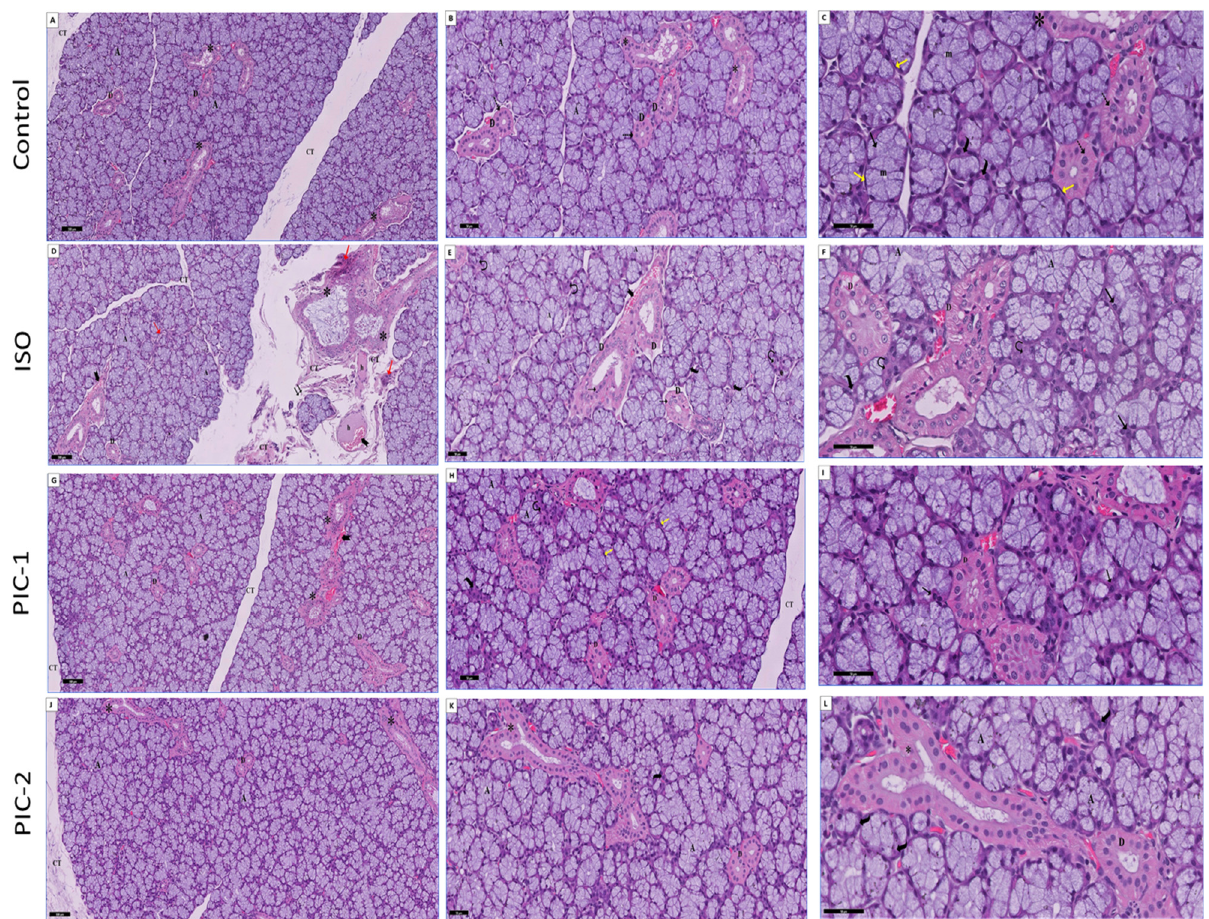
Figure 3. A section in the sublingual gland stained with HE from the control group ( A – C ) showing sublingual gland mucous acini and ducts appear with a fine network of interlobular connective tissue (CT). Each mucous acinus (A) consisted of large pyramidal mucous cells with abundant pale blue vacuolated cytoplasm. Acinar mucous cells contain flattened basal nuclei and pale eosinophilic cytoplasm ( ↑ ). A serous demilune is seen at the left of the acinus with rounded nuclei, and basal dark linear stain (wavy arrow). The striated duct is lined by columnar cells having eosinophilic cytoplasm and prominent cytoplasmic striations (dot arrow). The excretory ducts (*) have tall columnar epithelium with more apically located nuclei. Myoepithelial cells (yellow arrow) show a narrow cytoplasm and a very flattened nucleus, may be found wrapping ducts and some acini. (HE; A × 100, B × 200, C × 400). ISO group ( D – F ) showing markedly hypertrophic packed secretory mucous acini (A) with some areas with shrunken (curved arrow) loss of the acini ( ↑↑ ). A serous demilune is seen with vacuole-like structures (wavy arrow). Striated duct (D) appears disorderly arranged epithelium lining with loss of basal striation and marked vacuolation (dot arrow). Execratory ducts (*) appear with loss of pseudo-stratification and stagnated secretion in the lumen. Notice numerous mononuclear cellular infiltration (red arrow), hyalinization area (h), and dilated congested blood vessels (bifid arrow) in the connective tissue septa. (HE; D × 100, E × 200, F × 400; inset × 400). Low dose of PIC (PIC-1 group) ( G – I ) showing almost mucous acini (A) and striated ducts (D) appear nearly as control with a fine network of interlobular connective tissue (CT). A serous demilune at the left of the acinus (wavy arrow) and myoepithelial cells (yellow arrow) are seen. Excretory ducts (*) are possessed normal appearance of cell lining and are filled with a small amount of secretion. Notice few mononuclear cellular infiltrations (red arrow) and mild congested blood vessels (bifid arrow) (HE; G × 100, H × 200, I × 400; inset × 400). High dose of PIC (PIC-2 group) ( J – L ) showing marked improvement in the histological structure. The sublingual gland appears nearly as the control group. (HE; J × 100, K × 200, L × 400; inset ×